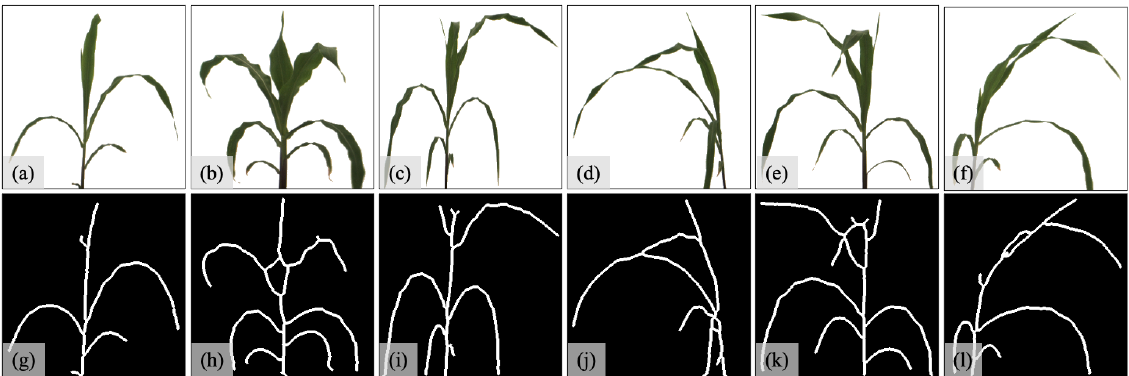
Figure 7. Dataset description: ( a – c ) are examples of original maize images in dataset M1O; ( d – f ) are examples of original maize images in dataset M2O; ( g – i ) correspond skeleton structure images for ( a – c ); and ( j – l ) correspond skeleton structure images for ( d – f